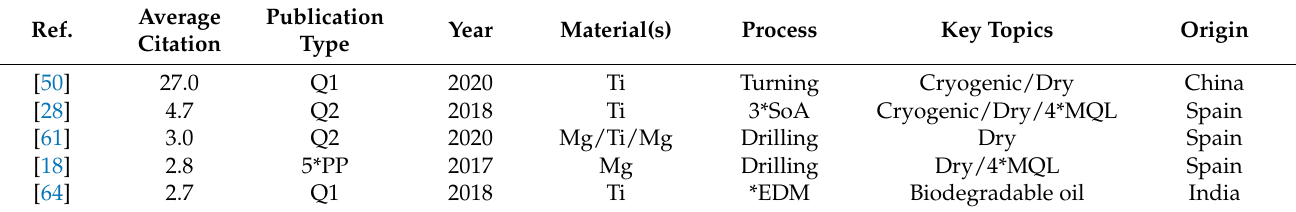
Table 4. Top 5 articles on sustainable machining and cooling